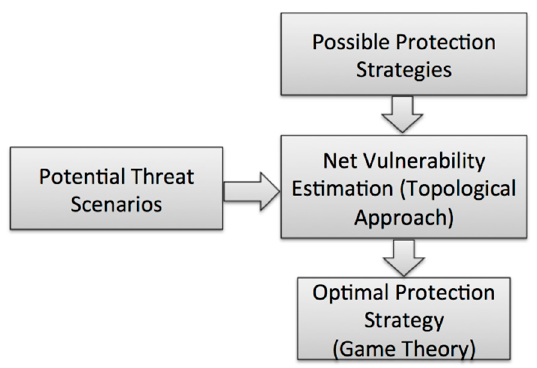
Figure 1. Protection Strategy Analysis Framework.